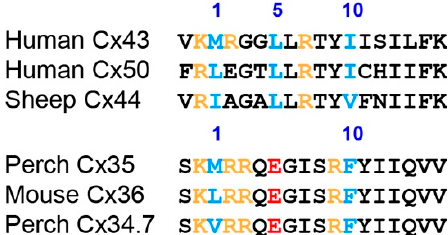
Figure 8. Sequences of cytoplasmic loop juxtamembrane calmodulin binding sites for human Cx43, Cx50, sheep Cx44 [9], Perch Cx35, Mouse Cx36 and Perch Cx34.7. The hydrophobic anchor residues making up the 1, 5, 10 motifs are designated above the sequences and highlighted in blue. Basic residues within the motif are highlighted orange. The position 5 anchor residue in Cx35/36 and Cx34.7 is replaced with an acidic glutamate (highlighted red), disrupting the motif.